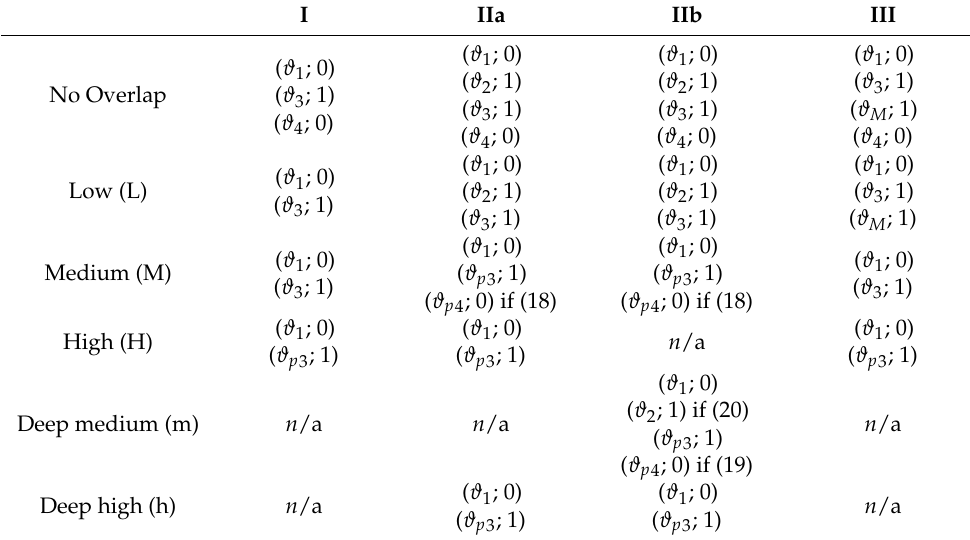
Table 3. Multiple flutes F shape key points for one period ( ϑ 1 ; ϑ 1 + φ z ) in